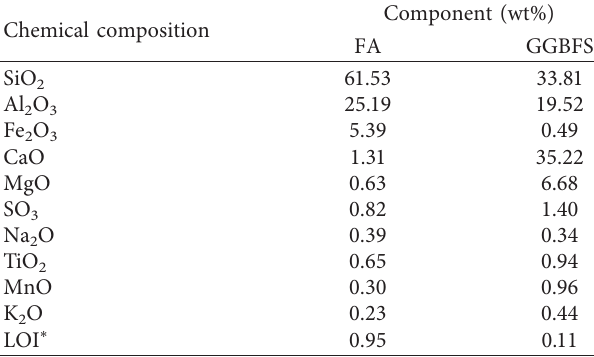
Table 1: Chemical composition of fly ash and GGBFS. Chemical